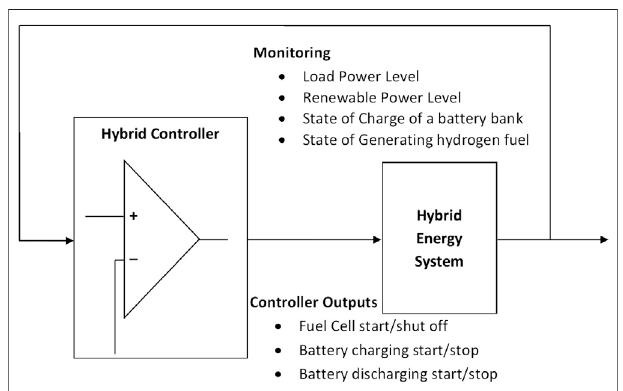
FIGURE 3 | Block Diagram of intelligent power management system for solar PV-wind-battery-fuel cell integrated system (Pipattanasomporn, 2004; Ani,